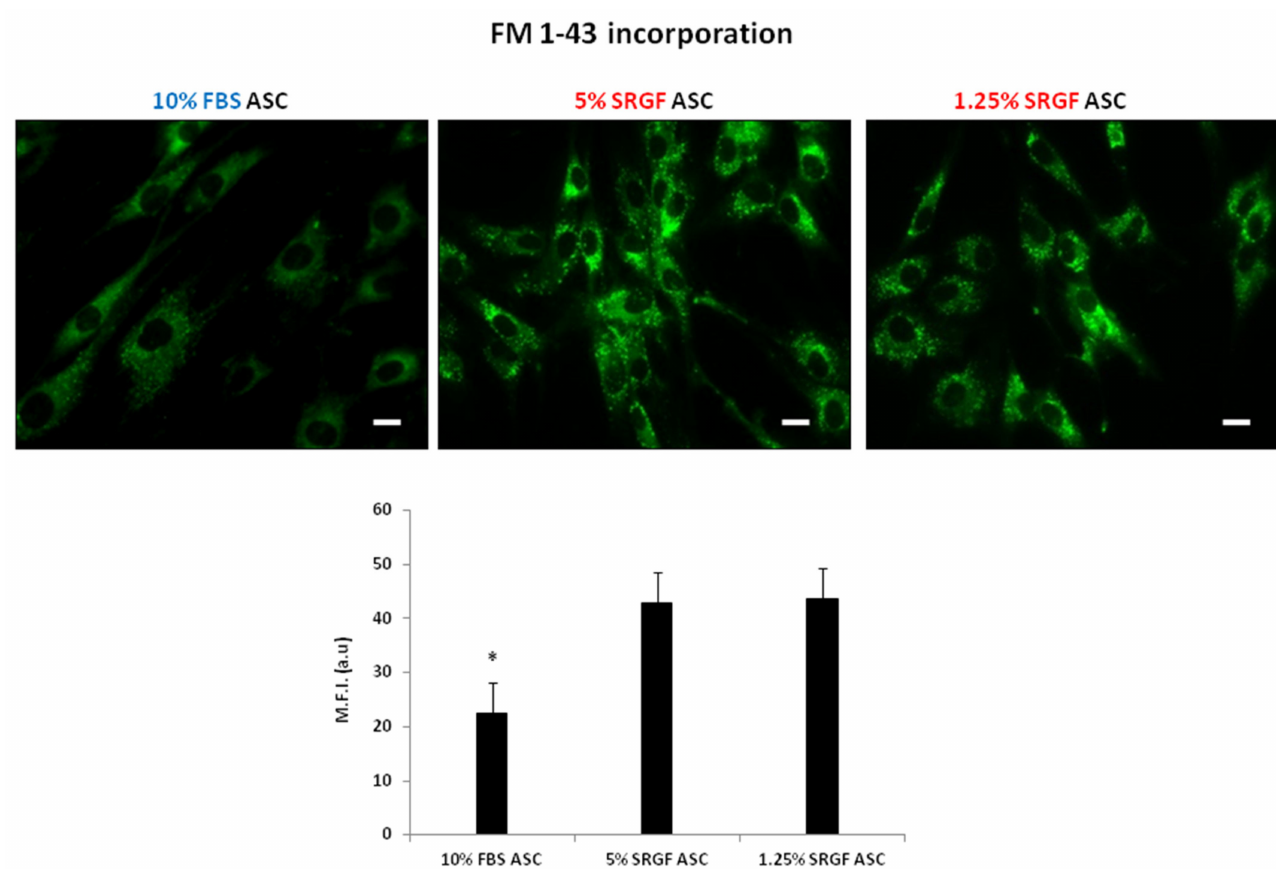
Figure 3. Figure 3 shows FM1-43 uptake efficiency in 10% FBS and 5% SRGF, and 1.25% SRGF ASC. Representative images as well as evaluation of mean fluorescence intensity as arbitrary units [M.F.I. (a.u.)] were reported. *; p < 0.01 vs. 5% SRGF ASC and vs. 1.25 % SRGF ASC. Scale bars: 10 µ m. Reported images and mean quantification values represent results derived from at least three independent experimental